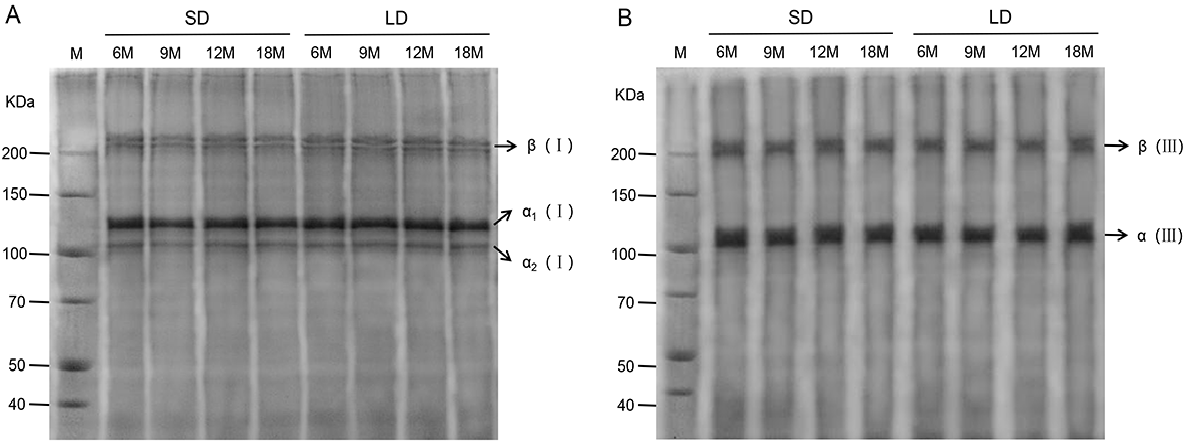
Figure 3. SDS-PAGE analysis of type Ⅰ collagen ( A ) and type Ⅲ collagen ( B ) from the semitendinosus (SD) and longissimus dorsi (LD) muscles at different growth stages. The first lane is the Marker (M).